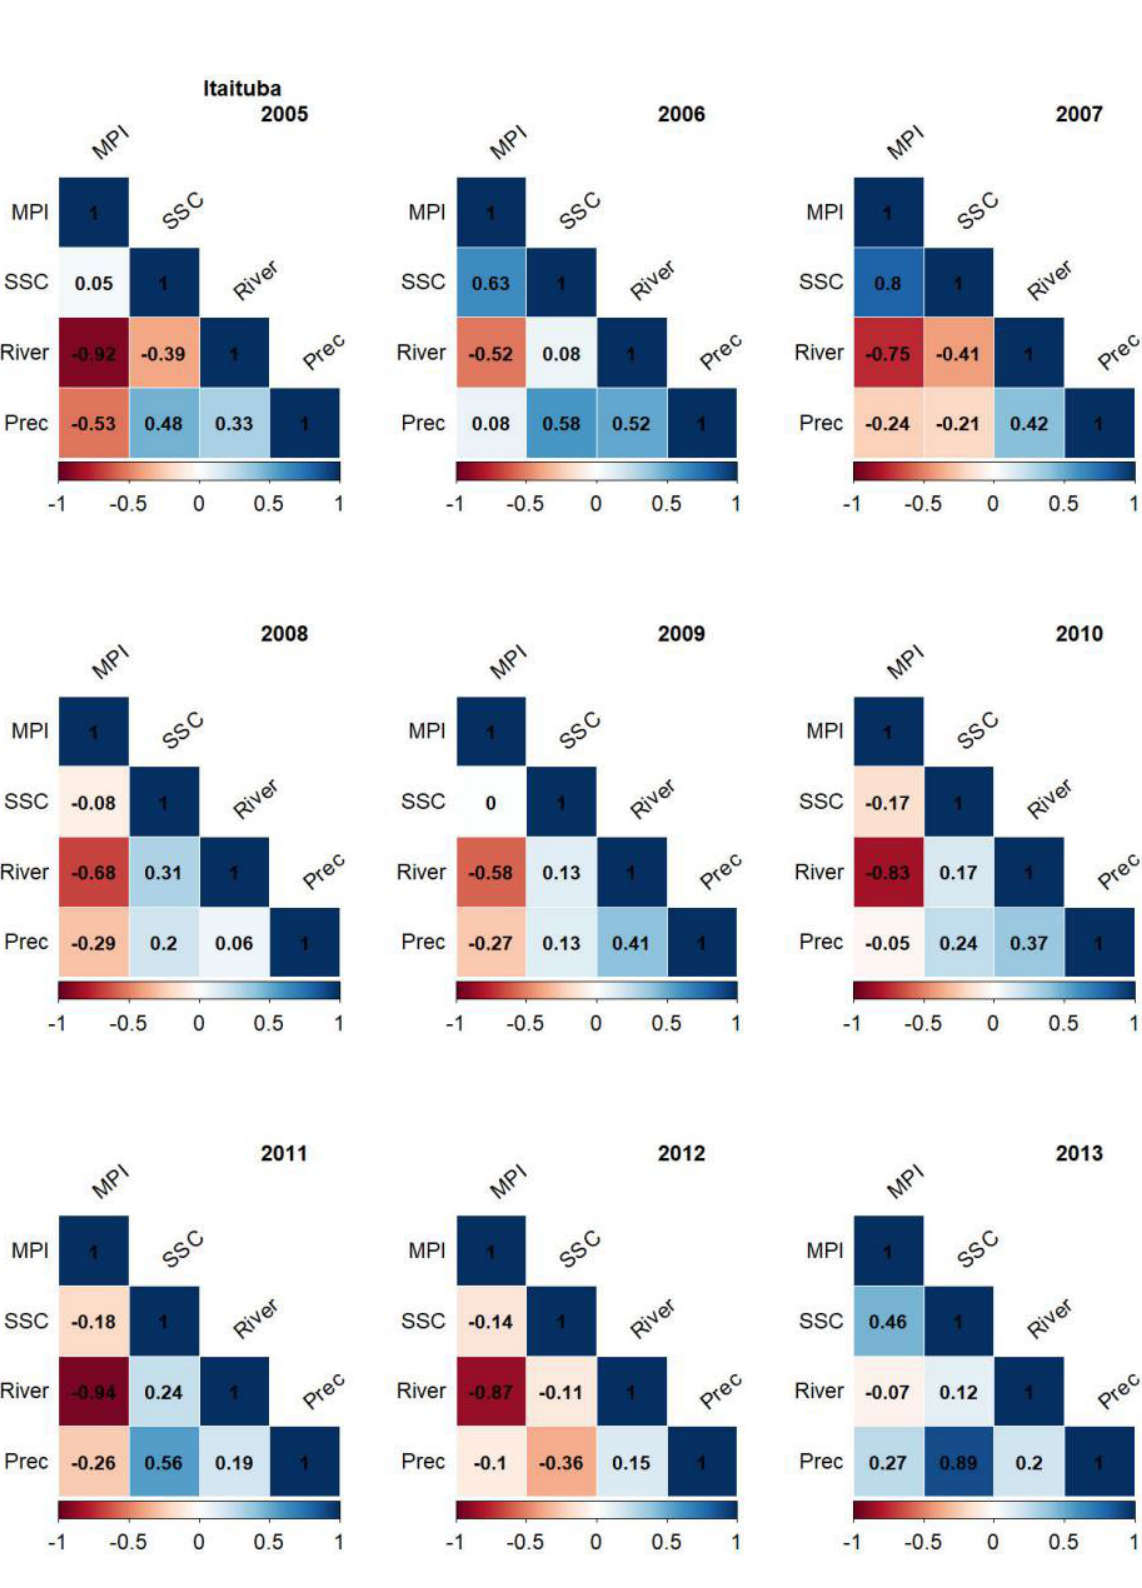
Figure 7. For the municipality of Itaituba, the relationship between monthly malaria parasite index (MPI), of suspended sediment concentration in rivers (SSC), river level (River), and precipitation (Prec), during the period 2005–2013.